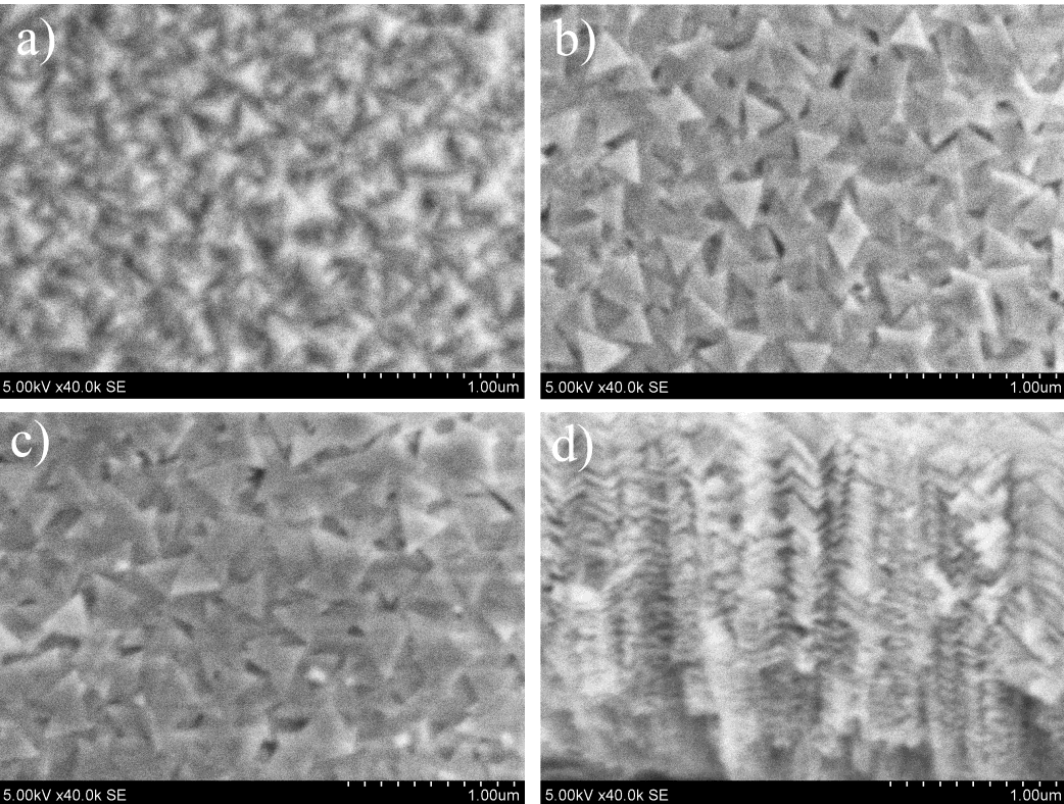
Figure 3. Topography ( a , b , c ) and cross section ( d ) images of thin SDC films deposited evaporating powder of 201.3 m 2 /g specific surface area with a 1.6 nm/s deposition rate. ( a ) 50 °C SiO 2 substrate, ( b ) 600 °C SiO 2 substrate, ( c ) 600 °C Al 2 O 3 substrate, and ( d ) 600 °C SiO 2 substrate.